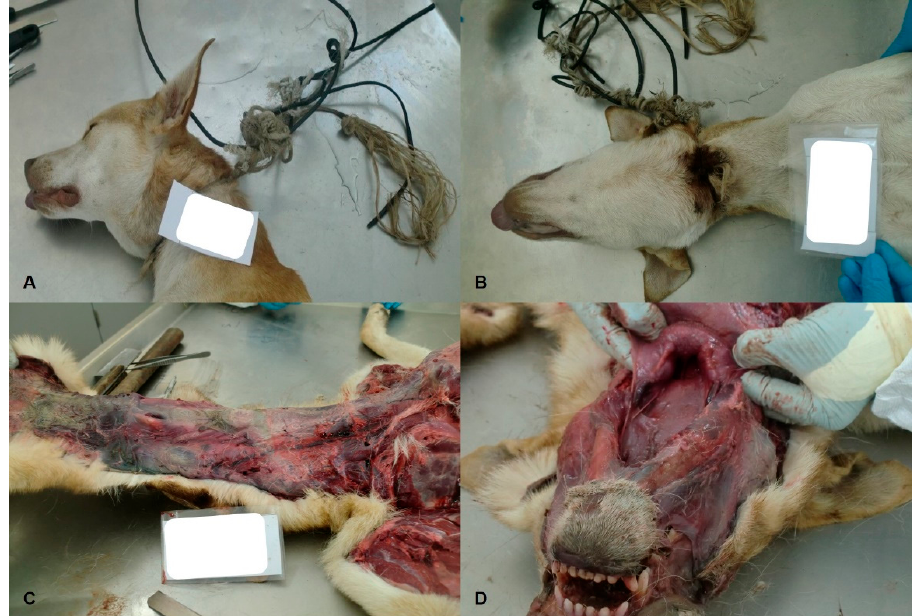
Figure 6. Loop strangulation ( A ) and groove with lacerating wound ( B ) in a dog. Hemorrhages in the neck ( C ) without loss of integrity of the hyoid bones ( D ) in an adult, crossbreed, male and medium-sized dog, hanged by rope in a tree, with incomplete suspension of the body, hanging through the lap area, with the hips and feet resting on the floor.